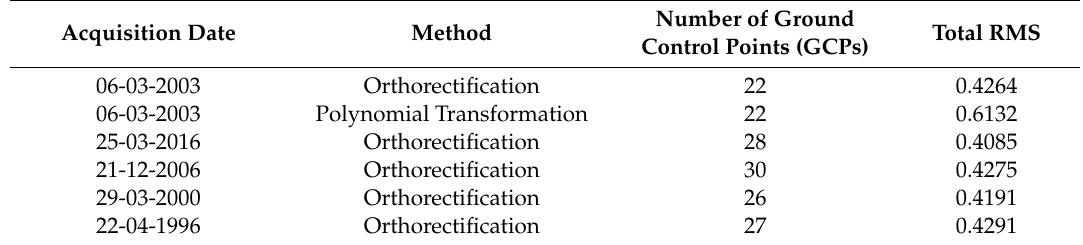
Table 2. The geometric correction accuracy using orthorectification